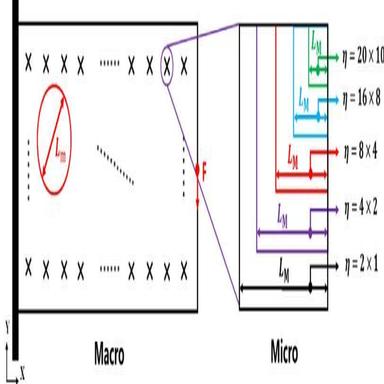
Sketch of the cantilever beam lattice structure and the design RVE domain.